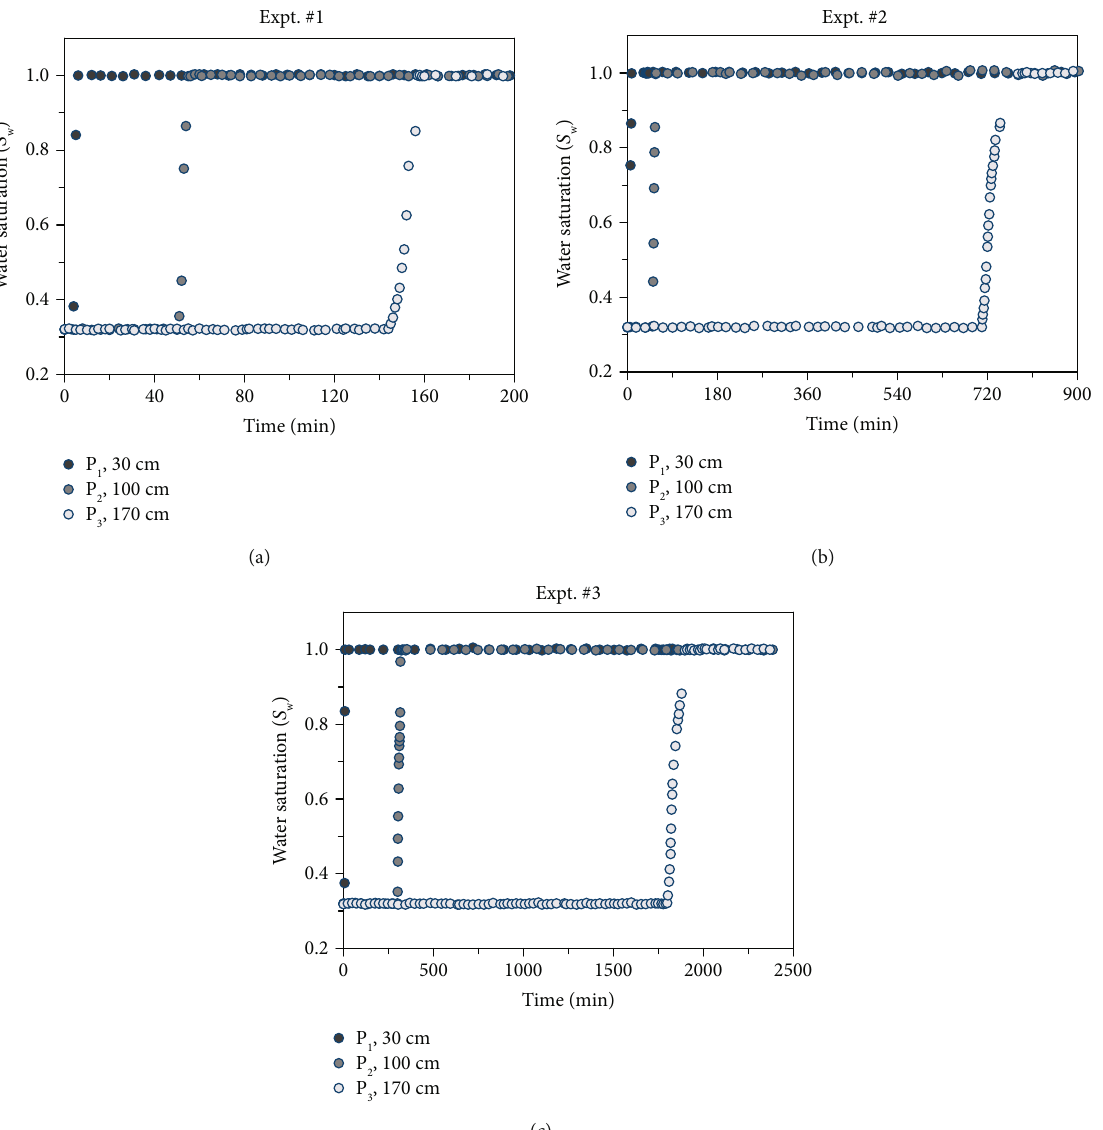
-P for Expts. 1 3